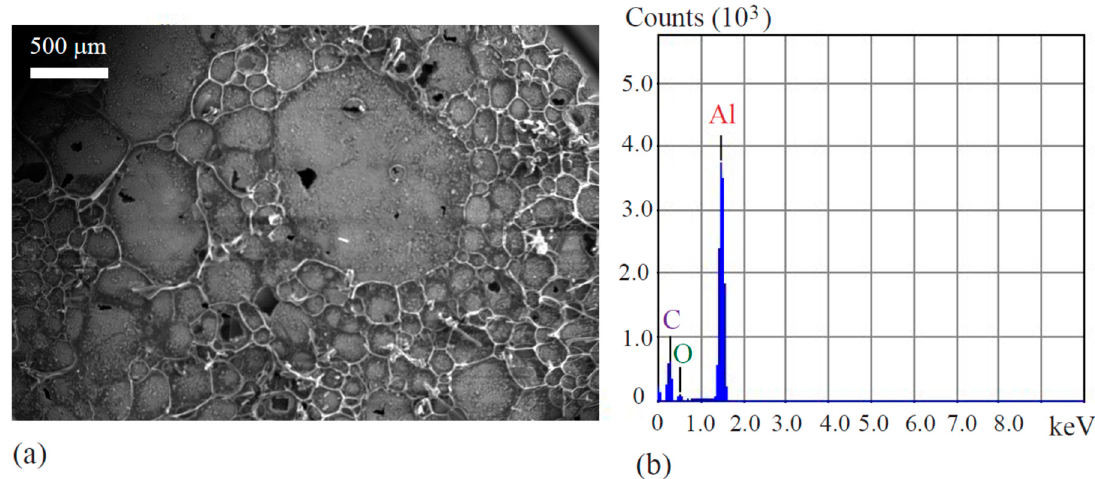
Figure 1. Scanning electron microscopic analysis results of the porous C / Al composite: ( a ) SEM image and ( b ) EDS spectrum.